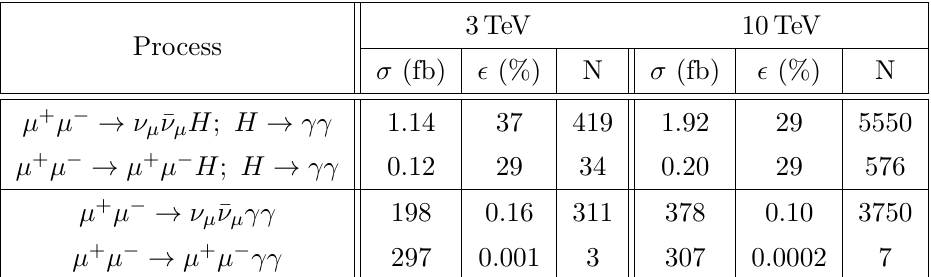
Table 5 . Signal and considered backgrounds for the H → γγ channel, after applying the cuts listed in the text.